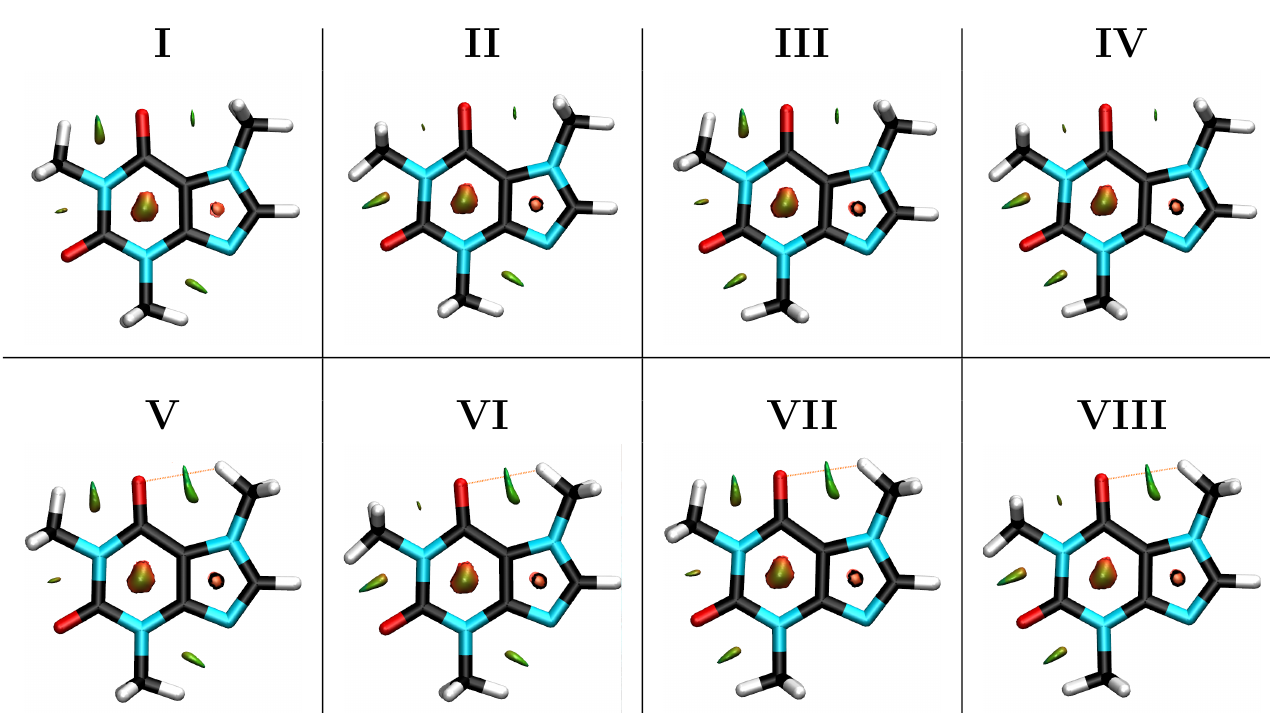
Figure 2. Eight possible structural conformers of caffeine holding one C–H bond from each methyl group in the aromatic plane, as determined from relaxed scans for the rotation of each methyl group. NCI green surfaces and bonding paths associated to the in–plane C–H bonds from the methyl groups are shown. NCI red surfaces showing the strong non–bonded overlap at the center of the aromatic cycles are also